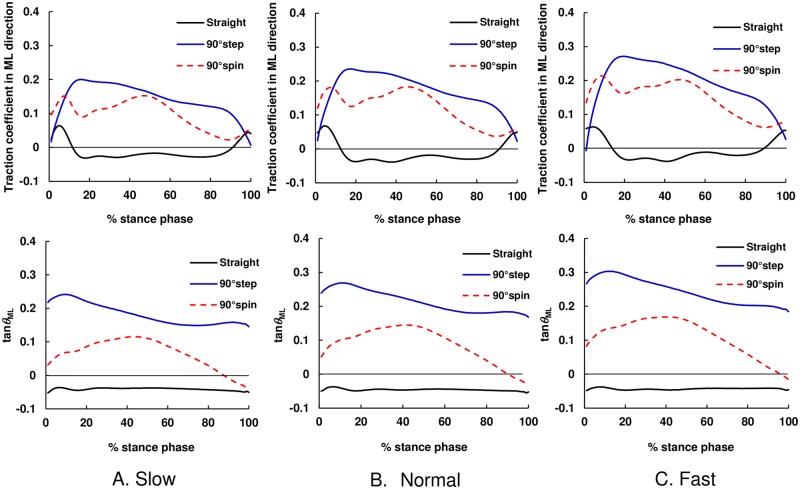
The average temporal pattern of mean values of traction coefficient and tangent of the COM–COP angle in the ML direction during straight walking and turning.The black solid line shows straight walking, blue solid line shows 90° step turns, and red dashed line shows 90° spin turns. (A) Slow, (B) Normal, and (C) Fast.